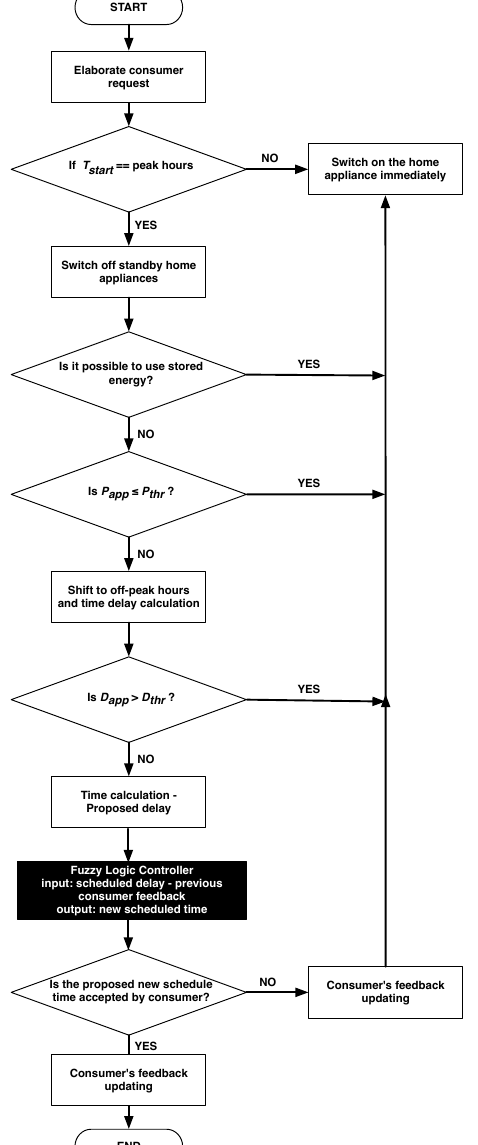
Figure 3. Home energy management (HEM) algorithm